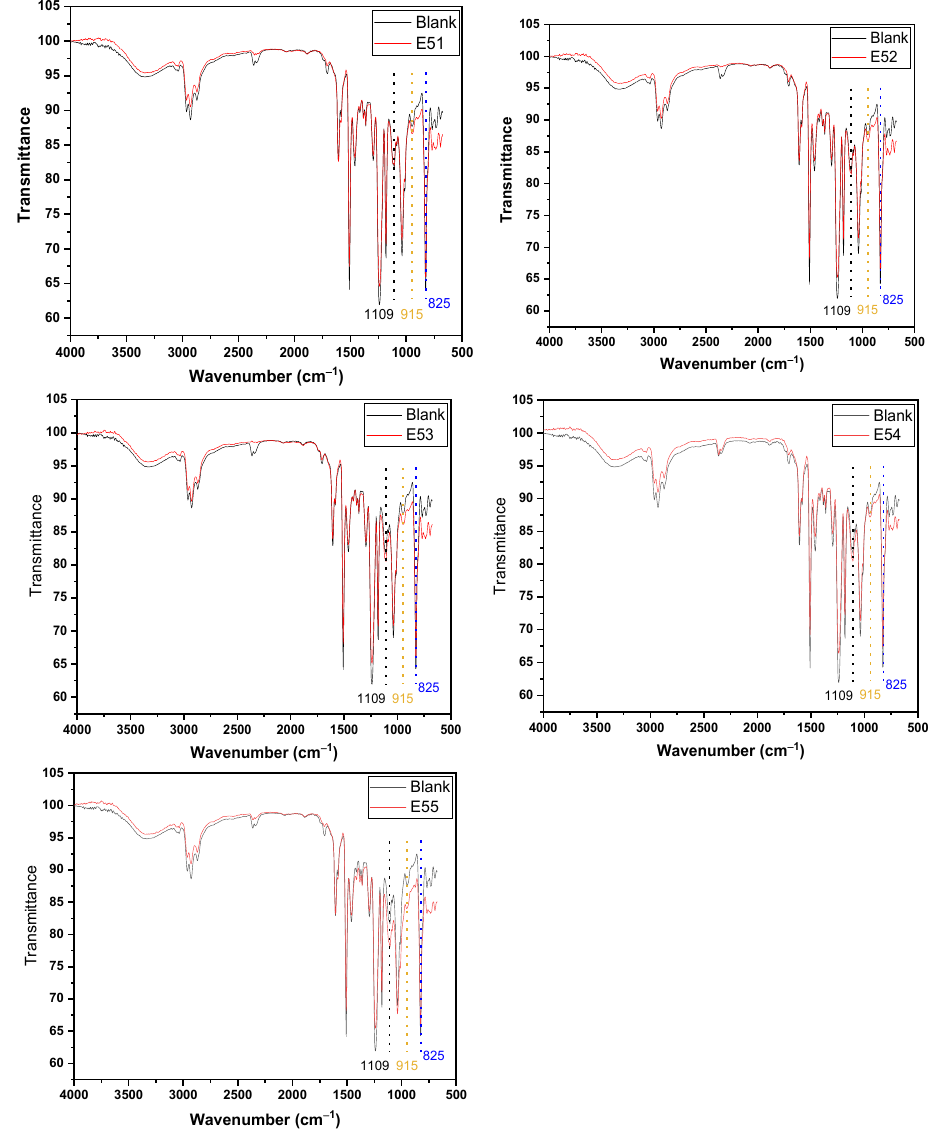
Figure 3. FTIR spectrum of blank and nanoparticle-incorporated coating samples in comparison. The peak intensity at 915 cm − 1 , which corresponds to the C–O vibrations of the epoxide group, were found to be 94 (blank), 95 (E51), 96 (E52), 96 (E53), 97 (E54), and 98 (E55). It was found that with increasing percentages of ZnO, the epoxy group vibration increased. The peak intensities at 1109 cm − 1 were recorded as 82 (blank), 82 (E51), 81 (E52), 80 (E53), 80 (E54), and 78 (E55), which correspond to the CN vibration intensities. These CN vibration intensities represent the curing of the epoxy and hardener; the reduction in the intensities suggests a decrease in the curing of the coating with the increasing percentage of nanoparticles. Another confirmation of the decrease in curing with the nanoparticle addition corresponds to the peak intensity at 825 cm − 1 . The intensities were recorded as 64 (blank), 66 (E51), 66 (E52), 67 (E53), 68 (E54), and 67 (E55), the increase in intensity with a higher nanoparticle percentage suggesting greater presence of the epoxide ring. Based on the evidence presented, it can be concluded that the presence of the nanoparticles in the system altered the curing behavior of the epoxy resin and hardener [26]. This effect was very small at lower percentages and very pronounced after a certain percentage followed by higher